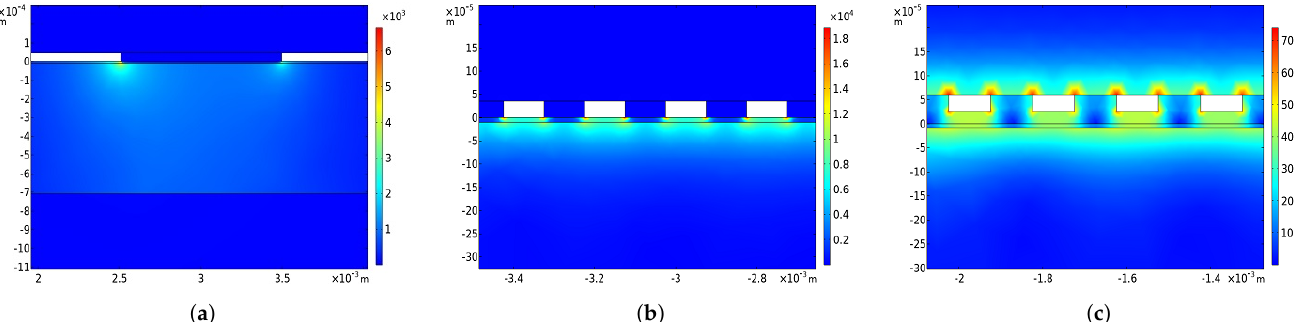
Figure 9. Illustration of the current density propagation. The X and Y axes are the size measures of the simulation in m. The color gradient shows the current density in Am − 2 . ( a ) Current density propagation through the skin and inside the circular conductance electrode: The charges penetrate vertically through the SC and move mainly in the epidermis/dermis due to higher conductivity. It is also visible that the charge exchange occurs in the edge between the electrodes and almost no charge leaves the outer surface. ( b ) Current density propagation through the skin and inside the interdigitated conductance electrode: The charges penetrate vertically through the SC and move mainly in the epidermis/dermis due to higher conductivity. ( c ) Current density propagation through the skin and inside the interdigitated capacitance electrode: A significant amount of the charges move inside the electrode due to the insulator layer between electrode and skin. The charges that penetrate into the skin again move vertically through the SC and connect in the epidermis/dermis due to higher